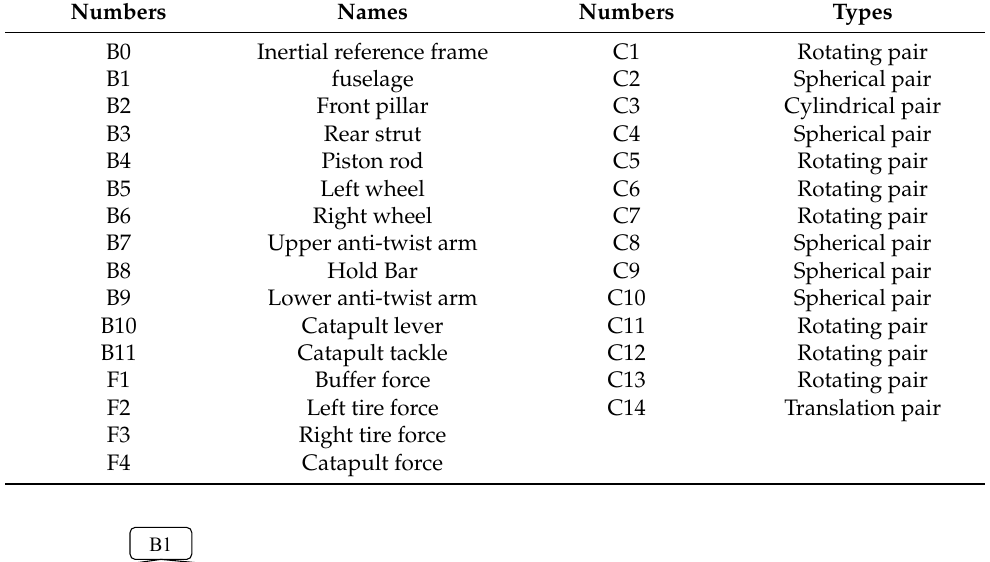
Table 2. Comparison table of some dynamics elements.